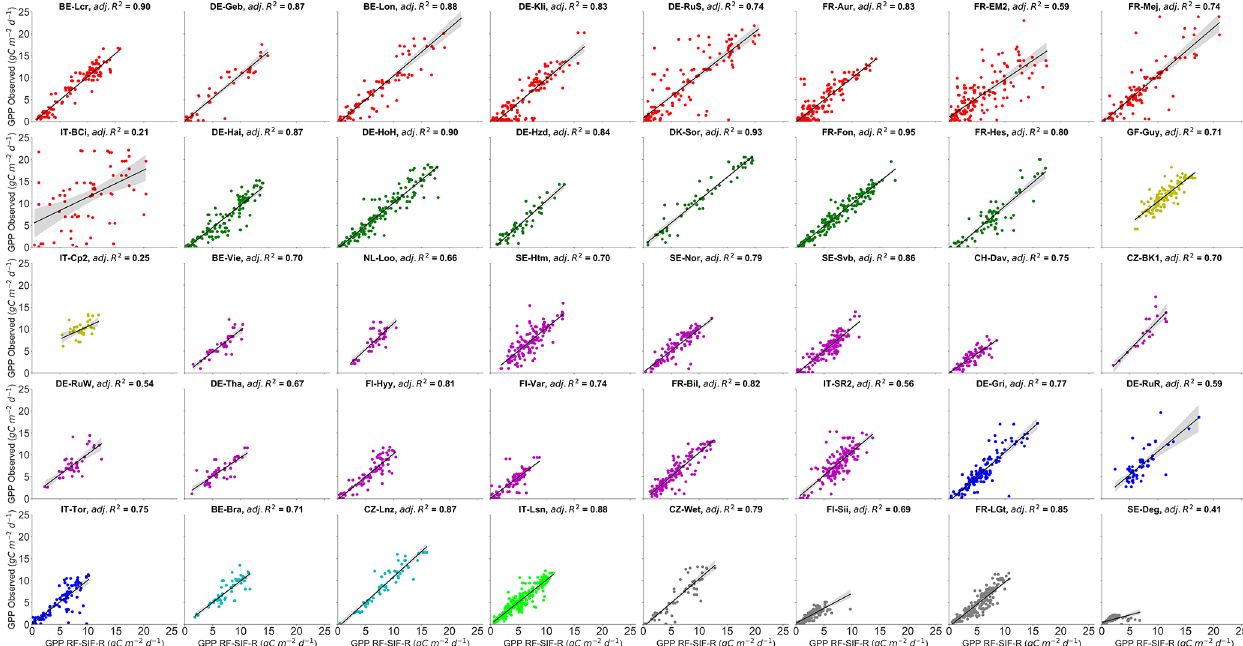
Figure 6. Site-specific scatterplots between observed GPP and RF-SIF- R -predicted GPP at daily timescales. The adj. R 2 represents the adjusted coefficient of determination of the relationships between observed GPP and predicted GPP. All pairwise relationships between observed GPP vs. predicted GPP were statistically significant at all sites (with p < 0 . 0001). The color code represents the eight different vegetation types encountered in the study sites: red stands for CRO, green for DBF, yellow for EBF, magenta for ENF, blue for GRA, can for MF, lime for OSH, and dim-grey for WET.